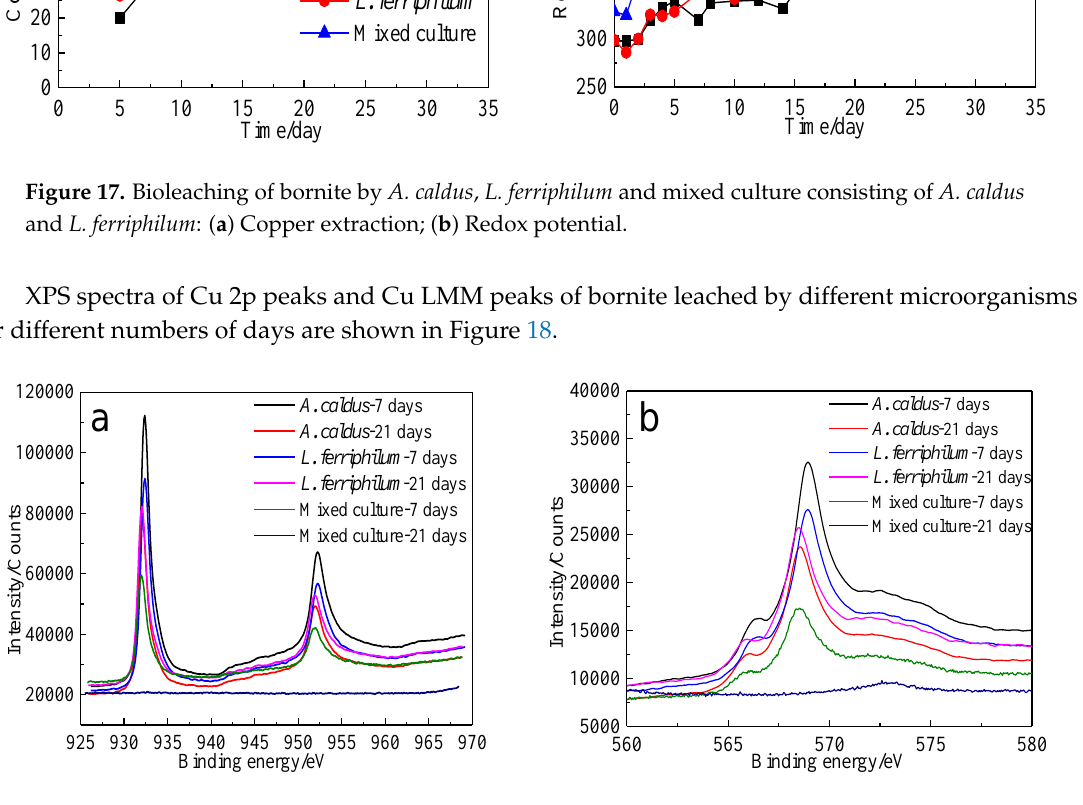
Figure 18. XPS spectra of Cu peaks of bornite surface leached by A. caldus , L. ferriphilum and mixed culture consisting of A. caldus and L. ferriphilum for 7 and 21 days, respectively (Implemented on the model of ESCALAB 250Xi of Al Kα X-ray source with 20 eV constant pass energy and 0.1 eV/step; Fitted by Thermo Avantage 5.52, C 1s 284.8 eV as reference, Shirley method, Gaussian-Lorentzian function): ( a ) Cu 2p peak; ( b ) Cu LMM peak.